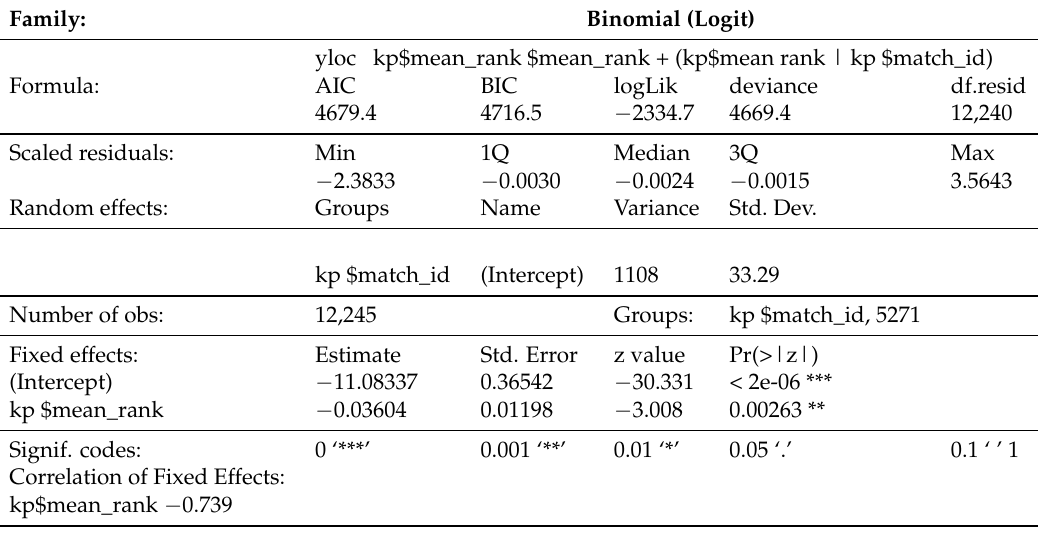
Table 5. Model 3: Generalized linear mixed model fit by